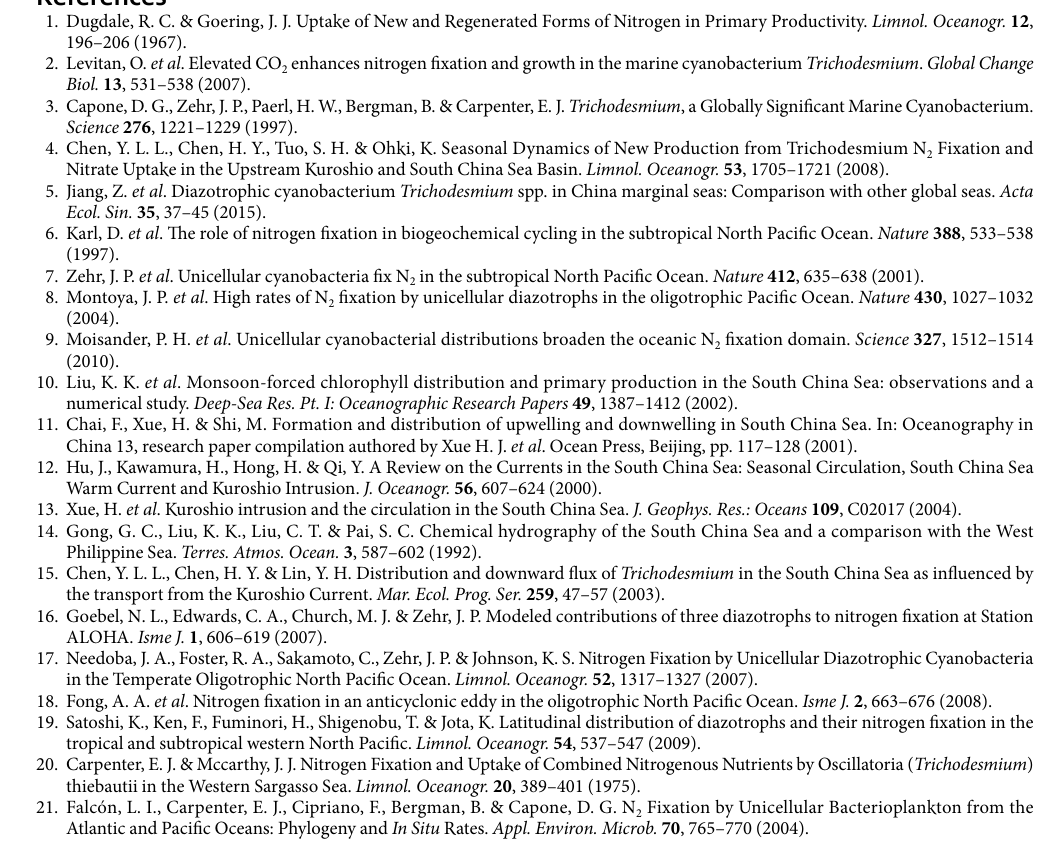
with HCl to remove residual inorganic carbon before they were moved into the scintillation vials, next the 10 mL scintillation cocktail (Ultima Gold; PerkinElmer; USA) were added. The activity of radioactive was counted using a Tri-Carb 2800TR liquid scintillation counter (Perkin-Elmer; USA). N 2 fixation activity was measured by acetylene reduction assay 3 . Sampling stations were grouped into four sectors according to their bottom depths and locations (Fig. 8): the nSCS shelf (Sta. S209, E503 and D104), the nSCS basin (Sta. E607 and SEATS), the ECS Kuroshio (Sta. DH54 and PN04) and the Luzon Strait (Sta. E404 and E406). All experimental incubations were run in trip- licate. 500 ml of surface seawater samples were introduced into a 600 mL HCl-rinsed polycarbonate bottles. After sealing with a butyl rubber stopper, 20 mL of acetylene was injected by replacing the same volume of headspace. Seawater samples that passed through a 10 μ m mesh were also prepared for incubation of the surface samples in the same manner as whole seawater samples. Samples were incubated for 24 h in an on-deck incubator cooled by running water pumped up from a 5 m depth. At Sta. SEATS, subsurface samples were also obtained from 100%, 50%, 10%, 3% and 1% light depths relative to that of the surface to determine N 2 fixation at subsurface layers. The light intensity of the subsurface samples was adjusted to the in situ density using neutral density filters. N 2 fixation by Trichodesmium was also measured by acetylene reduction assay. A total of 6 sampling stations were occupied to determine the N 2 fixation rate of Trichodesmium (Fig. 8). Two sites were located in the ECS Kuroshio (Sta. PN04 and DH12), one site in the nSCS shelf (Sta. S209), one site in the Luzon Strait (Sta. E404) and two sites in the nSCS basin (Sta. SEATS and S504). Trichodesmium colonies were collected by a 76 μ m mesh phytoplankton net towing gently in the surface water. Trichodesmium colonies were manually picked immedi- ately by using a plastic bacteriological transfer loop and placed into a glass container with GF/F filtered seawater. Approximately 30–50 colonies were transferred to a 25 ml glass vial with 15 ml filtered seawater. The vials were sealed with butyl rubber stoppers. After injection of 2 ml acetylene, vials containing Trichodesmium colonies were incubated for 4–6 h in the daytime. To evaluate N 2 fixation of Trichodesmium , their activity at each station was calculated from their numerical abundance and their N 2 fixation activity per trichome. At the end of the incubation, the gas phase of the vials was sampled with a 100 μ l gastight syringe (Agilent) and manually injected into a flame ionization gas chromatograph (GC6890N, Agilent). The temperatures of injector, detector and oven were set at 250 °C, 200 °C and 60 °C respectively. The carrier gas was helium at the highest purity available at a flow rate of 9 mlmin − 1 . The supply of H 2 and air for the FID were 30 mlmin − 1 and 300 mlmin − 1 , respectively. The column was 20m-long wide-bore fused silica (0.53 mm inner diameter) packed with Porapak U (Agilent). The ethylene production during the incubation was calculated as Capone 62 . The produced ethylene was converted to fixed nitrogen with a molar ratio of 4:1. After the assay, the incubated samples were fixed with 1% neutralized formaldehyde for the later enumeration of Trichodesmium